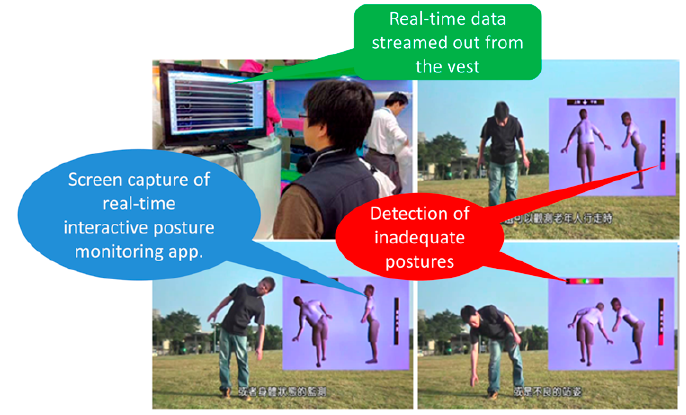
Figure 4. Interactive posture monitoring and real-time warning application.